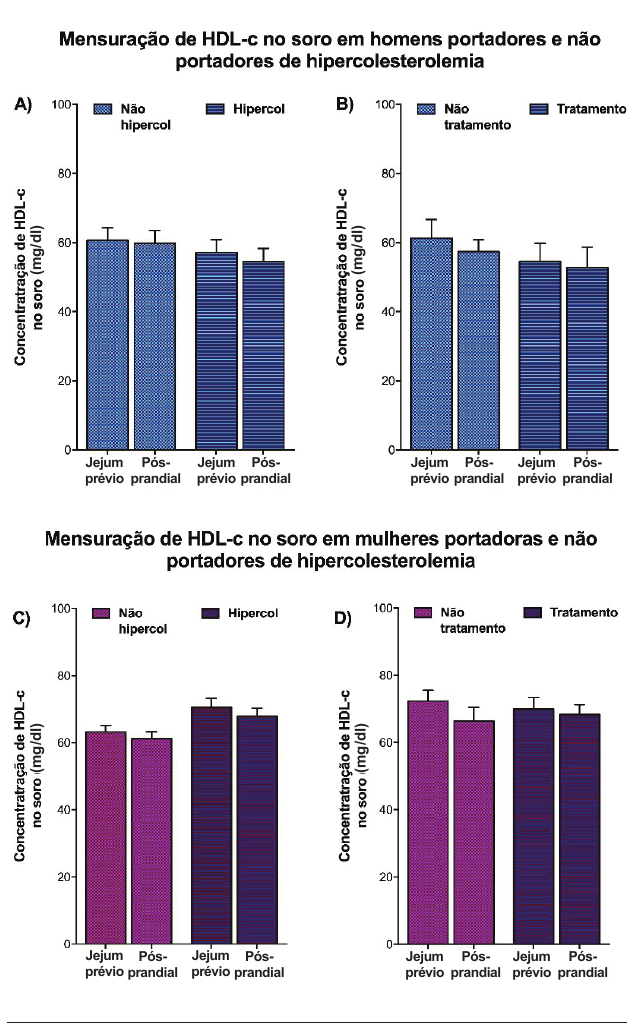
Figura 5 − Concentração de HDL-c no soro de indivíduos portadores e não portadores de hipercolesterolemia mensurada após jejum prévio de 12 horas e de forma pós-prandial A figura mostra a concentração de HDL-c no soro de indivíduos do sexo masculino não portadores ( n = 13) e portadores ( n = 8) de hipercolesterolemia (A), e de indivíduos do sexo masculino portadores de hipercolesterolemia que fazem uso de medicamentos orais ( n = 5) ou não ( n = 3) (B). Também mostra a concentração de HDL-c no soro de voluntários do sexo feminino não portadores ( n = 15) e portadores ( n = 14) de hipercolesterolemia (C), e de voluntários do sexo feminino portadores de hipercolesterolemia que fazem uso de medicamentos orais ( n = 8) ou não ( n = 6) (D). Os dados representam a média ± o erro padrão da média (teste t de student para amostras pareadas). HDL-c: colesterol da lipoproteína de alta